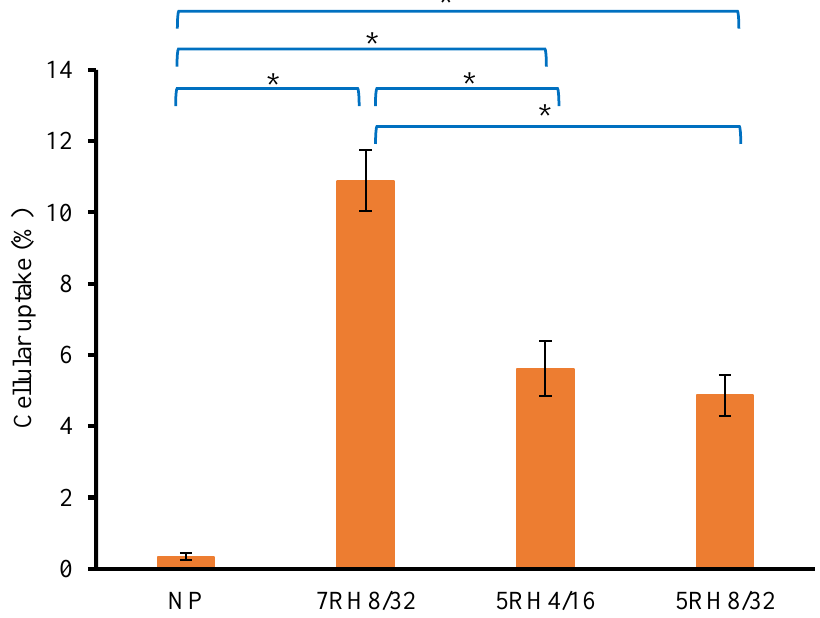
Figure 6. Percent cellular absorption of 5RH4/16, 5RH8/32, and 7RH8/32 NP powders after 3 h of exposure to each formulation. ( n = 3) (* p < 0.05). Table 4. Remaining percentages of NP after storage under accelerated conditions (relative humidity 40 ◦ C/75%) and ambient (25 ◦ C) ( n =